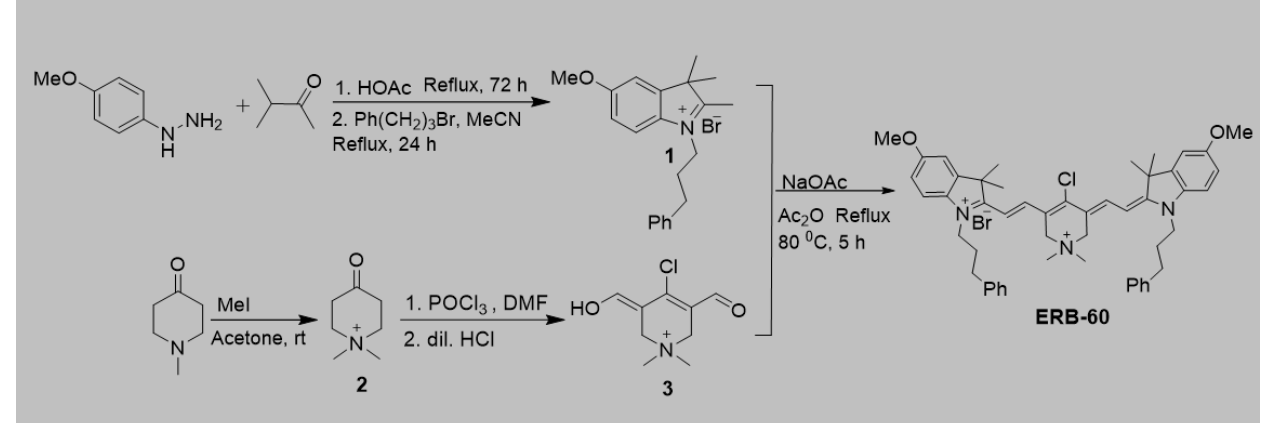
Table 1. Physicochemical properties of ERB-60 calculated using ChemAxon. The data calculated (at pH 7.4) include: logD, polarizability, dipole moment (debye), number of rotatable bonds, volume (Å 3 ), molecular surface area (Å 3 ), and molecular weight